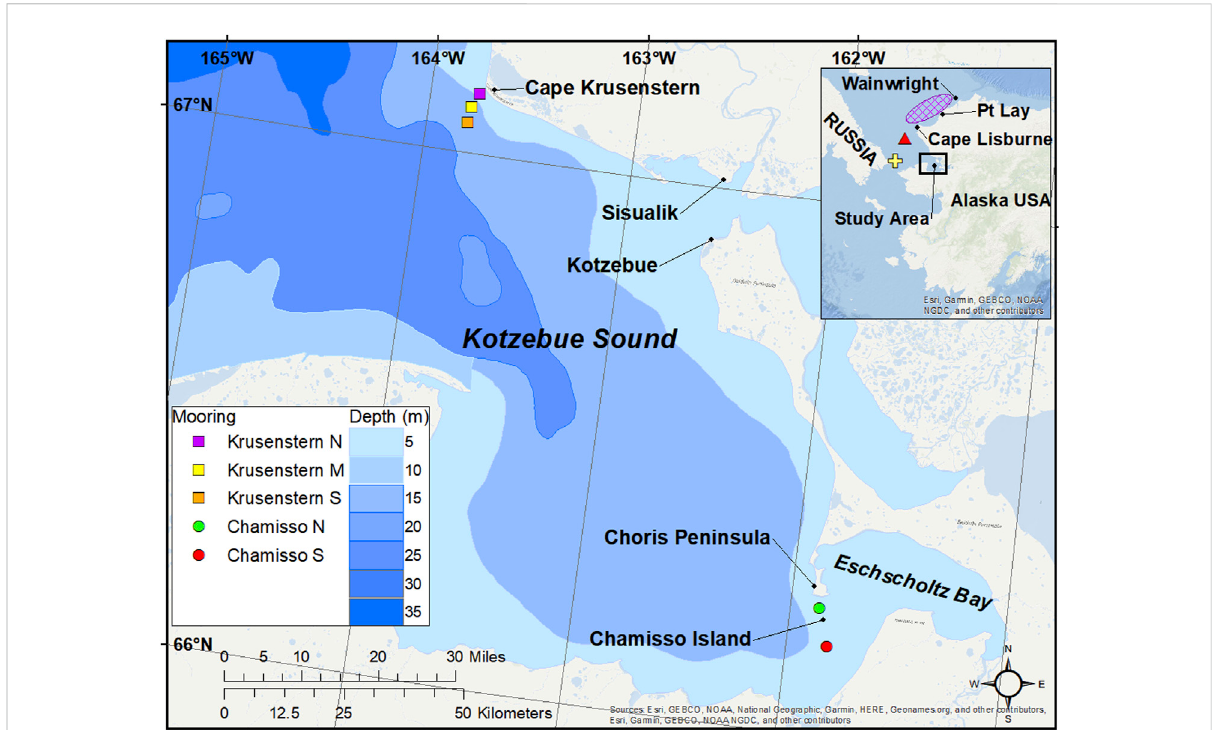
FIGURE 1 Map of the study area in Kotzebue Sound, Alaska. Passive acoustic mooring locations are indicated in colors as squares (Cape Krusenstern) or circles (Chamisso Island) for the summer 2013 pilot study, and the 2014 – 2016 study. Map insert: Previously published study areas by other authors, yellow cross for Stafford et al. (2019), red triangle for Madrigal et al. (2021), purple gridded area for Hannay et al.